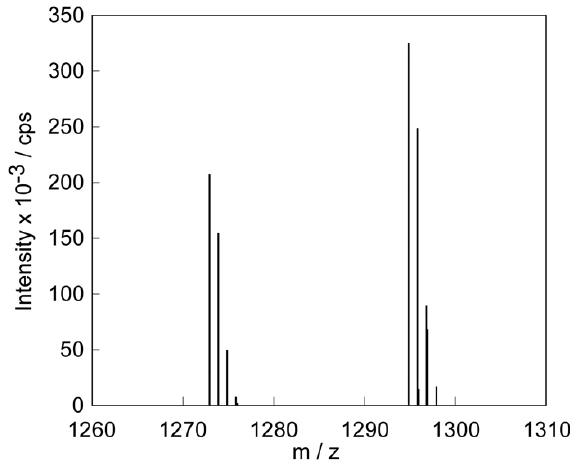
Figure A2. MALDI-TOF-MS spectrum of the peptide lipid. Table A1. The assignment of crystal faces from diffraction peak and relative intensity shown in Figure 5, and standard XRD data of calcite phase of CaCO 3 . Experiment